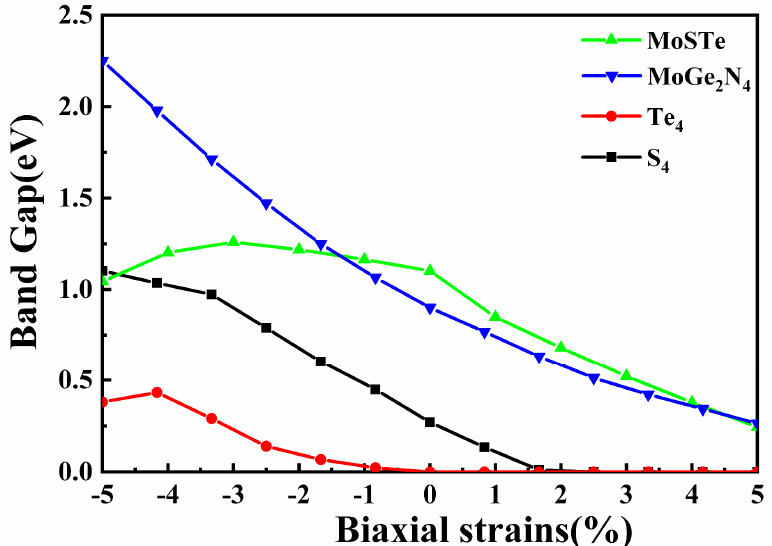
Figure 5. Effect of applied biaxial strain on band gap for Janus MoSTe, MoGe 2 N 4, Te 4 – MoSTe/MoGe 2 N 4 vdWH, and S 4 –MoSTe/MoGe 2 N 4 vdWH,